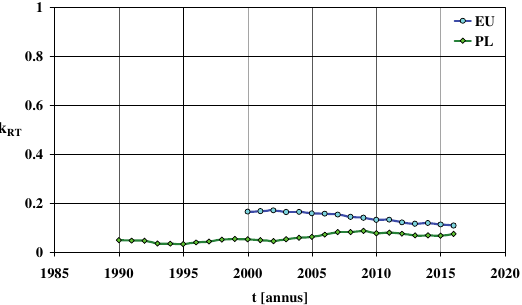
Fig. 18. Share of annual emission from motor vehicles comparing to the total annual emission for particulate matter PM2.5: in Poland – PL